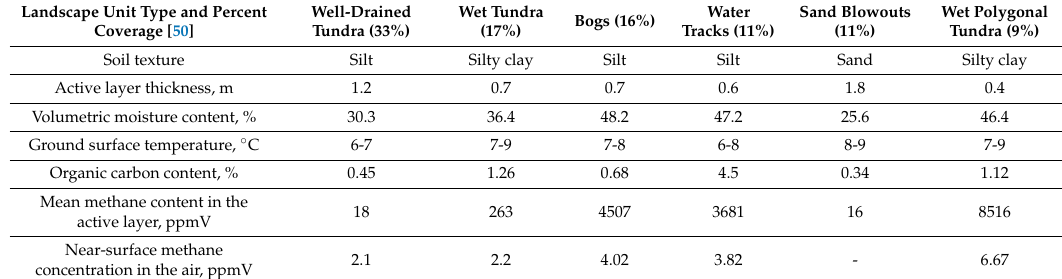
Table 3. Spatial variability of the methane in the active layer of various types of landscape units characteristic of typical tundra of the Marre-Sale site.